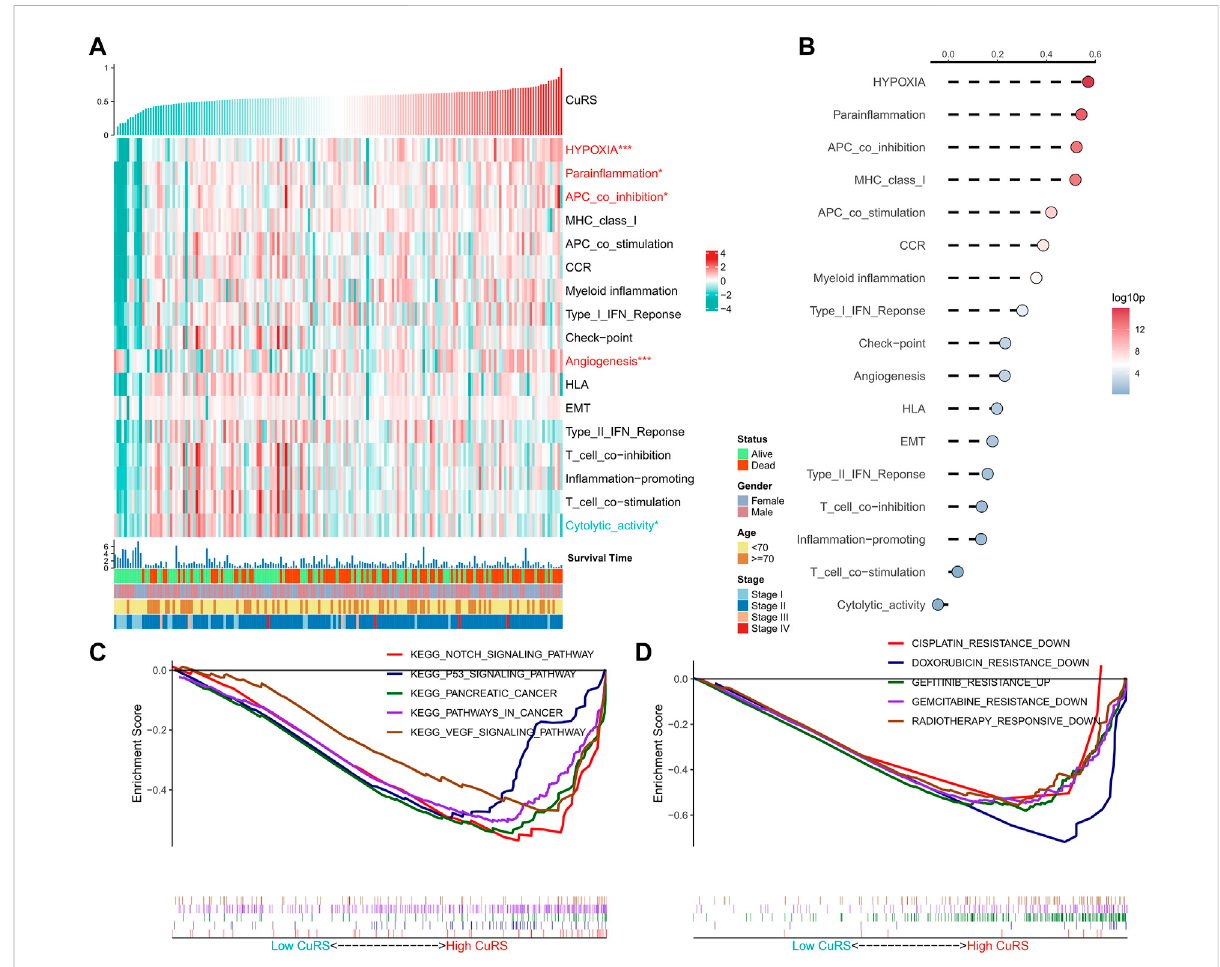
FIGURE 4 Functional analysis of the CRG-based risk model. (A) Heat map showing the correlation between CuRS, biological pathway activity, and clinical characteristics; (B) Correlation analysis for CuRS and biological pathways; (C) GSEA plot showing fi ve KEGG pathways of interest in the high-CuRS group; (D) GSEA plot showing the responses of patients in the high-CuRS group towards chemotherapy and